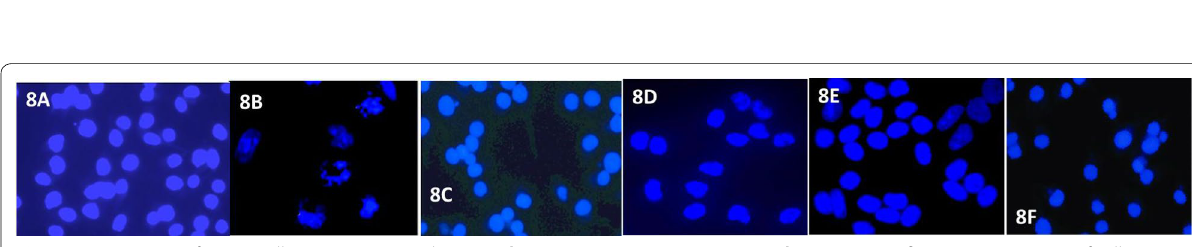
Fig. 8 DAPI staining of CNE‑2 cells on treatment with ( a ) PBS; b CuO NPs; c FOL‑PLGA‑CuO NPs; d CD‑1; e CD‑2; f CD‑3. DAPI staining of cells treated with CuO nanoparticles show dead and disfigured cells not visible in other